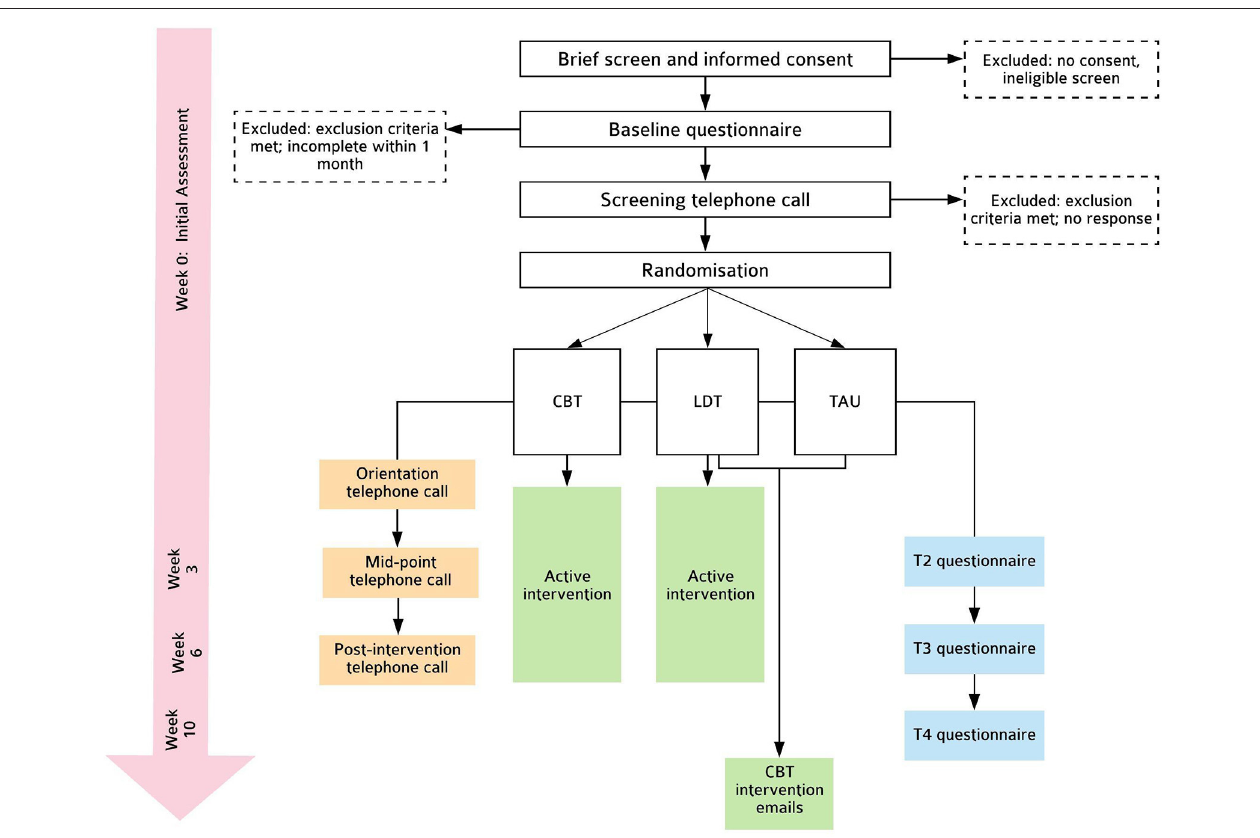
FIGURE 1 | Flowchart of trial